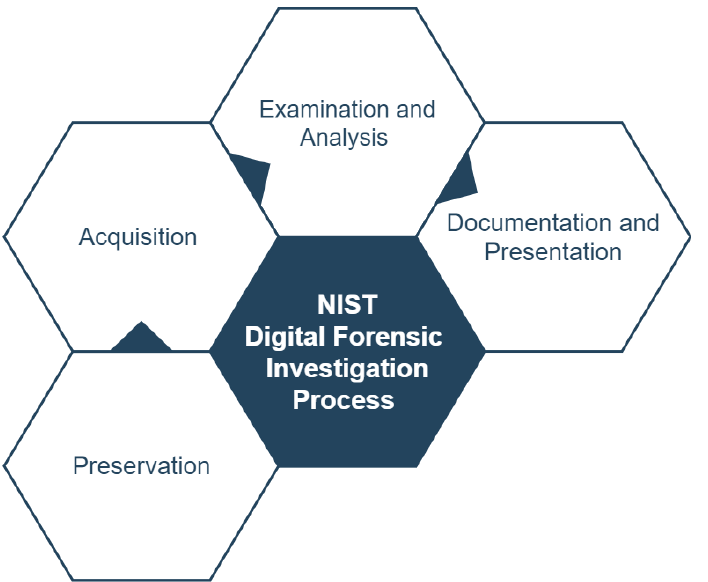
Figure 4. NIST high-level guidelines on mobile device forensics in [60].